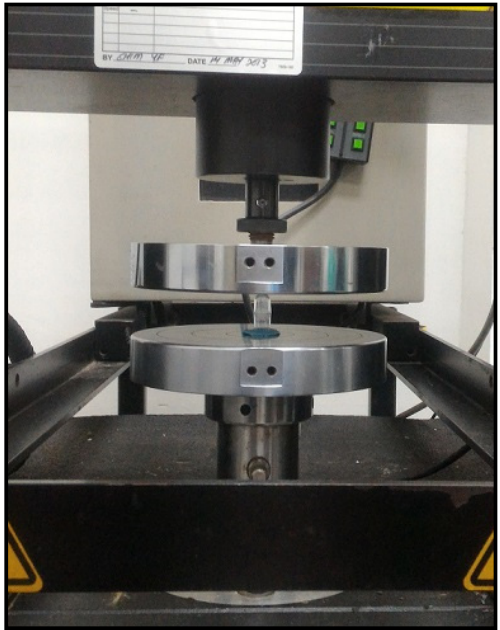
Figure 2. Photo of surface texture of capsule ( a ) without modification (smooth), ( b ) roughened, and ( c ) weak lines.